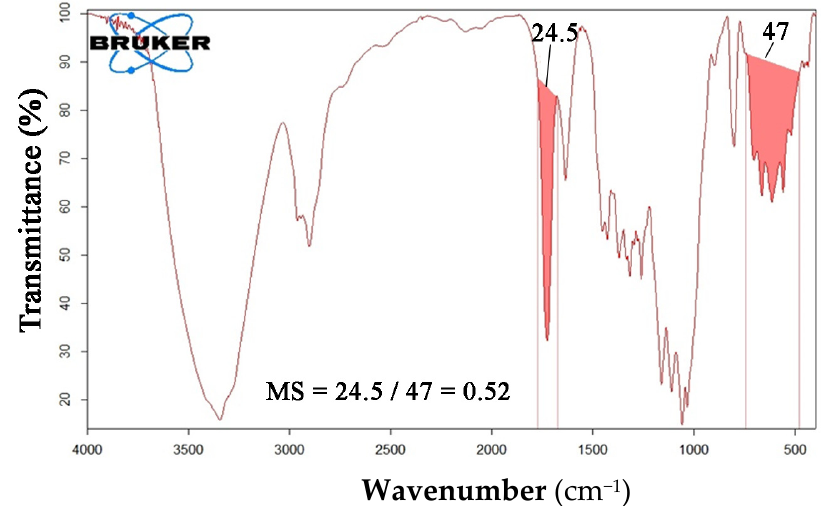
10 of 21 Figure 4. ( a ) FT-IT analysis of ONC-GMA in salt form highlighting peaks integrated for MS calculations. ( b ) Comparison between FT-IR spectra of ONC-GMA in its salt form (blue) and ONC